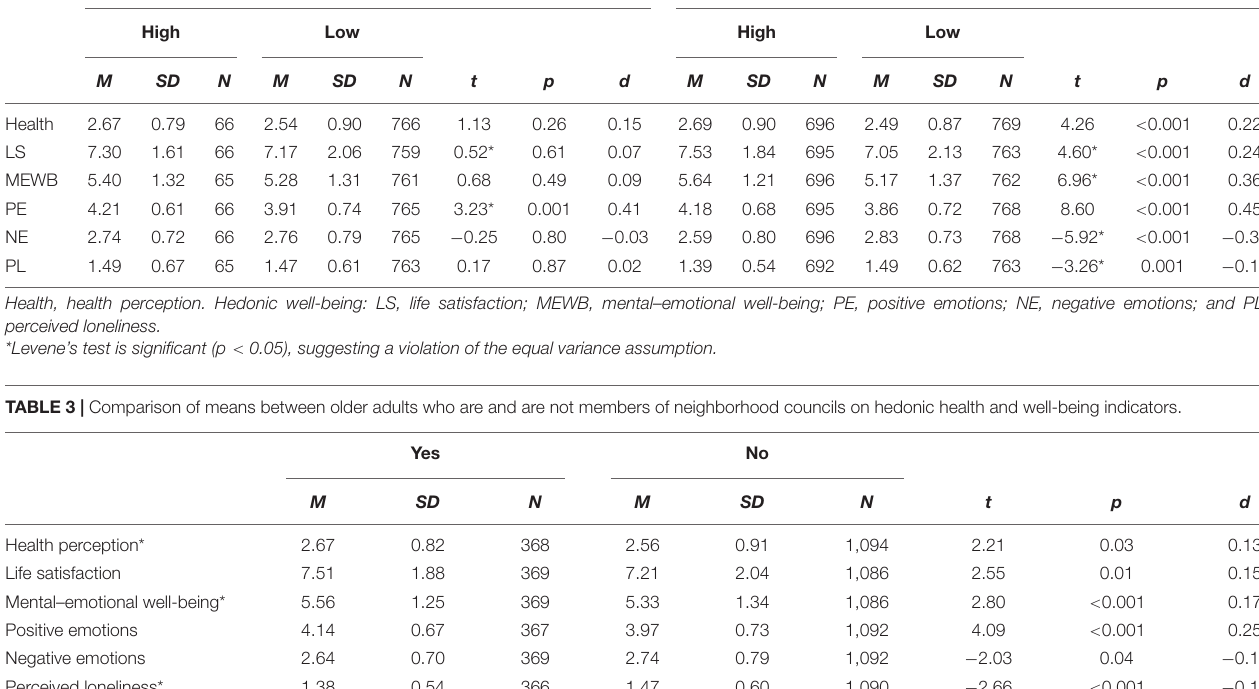
TABLE 2 | Comparison of the average of health and well-being in older adults according to their level of high or low membership and neighborhood social identification. Membership